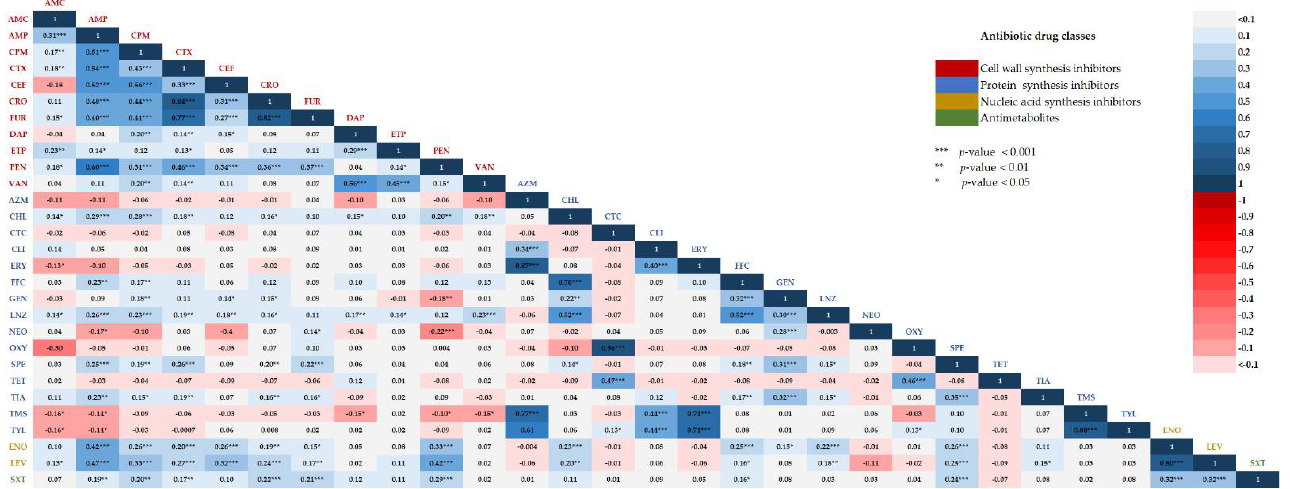
Figure 4. Pairwise correlation between two antimicrobial susceptibility statuses. Positive correlations are visualized in blue blocks and negative correlations in red blocks. The color intensity of the text labels is proportional to the correlation coefficients. Significant p -values corresponding to the correlation coefficient are indicated with asterisk (*** p -value < 0.001; ** p -value < 0.01; * p -value < 0.05). Cell wall synthesis inhibitor antibiotics: AMC, Amoxicillin/Clavulanic acid; AMP, Ampicillin; CEF, Ceftiofur; CPM, Cefepime; CRO, Ceftriaxone; CTX, Cefotaxime; DAP, Daptomycin; ETP, Ertapenem; FUR, Cefuroxime; MEM, Meropenem; PEN, Penicillin; VAN, Vancomycin. Protein synthesis inhibitor antibiotics: AZM, Azithromycin; NEO, Neomycin; CHL, Chloramphenicol; CLI, Clindamycin; CTC, Chlortetracycline; ERY, Erythromycin; FFC, Florfenicol; GEN, Gentamicin; LNZ, Linezolid; NEO, Neomycin; SPE, Spectinomycin; TET, Tetracycline; TMS, Tilmicosin; TYL, Tylosin tartrate; TIA, Tiamulin; OXY, Oxytetracycline. Nucleic acid synthesis inhibitor antibiotics: ENO, Enrofloxacin; LEV, Levofloxacin. Antimetabolite antibiotic: SXT, Trimethoprim/sulfamethoxazole.